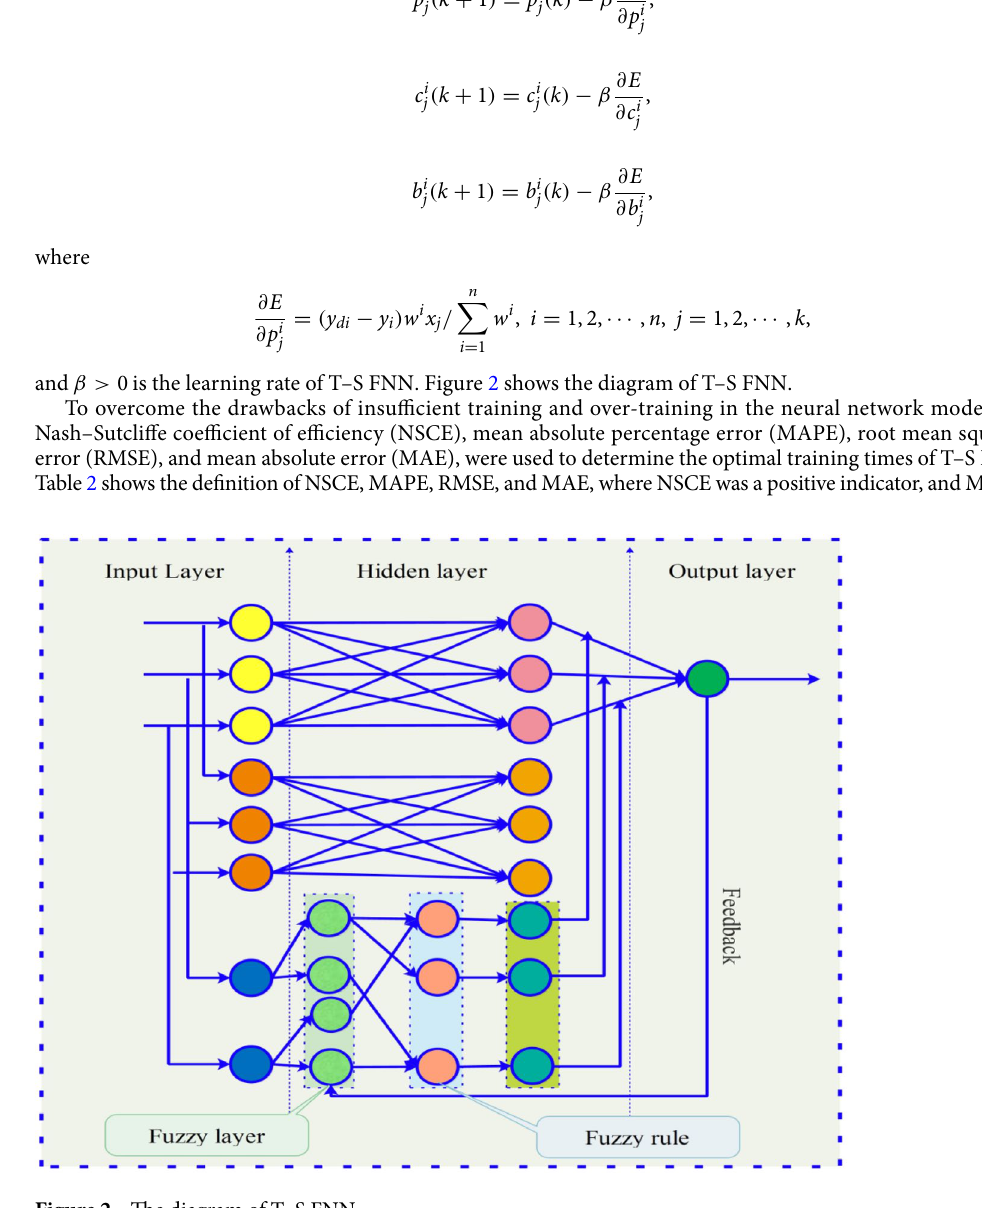
Figure 2. The diagram of T–S